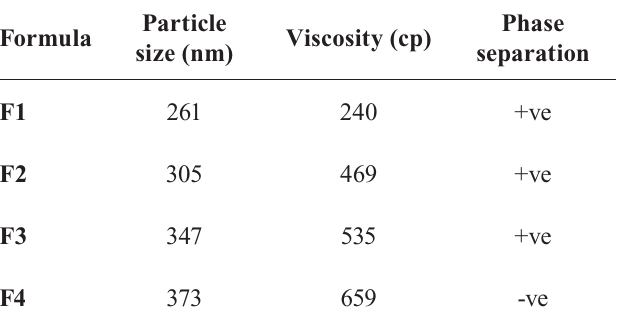
TABLE II - Particle size distribution analysis, viscosity, and